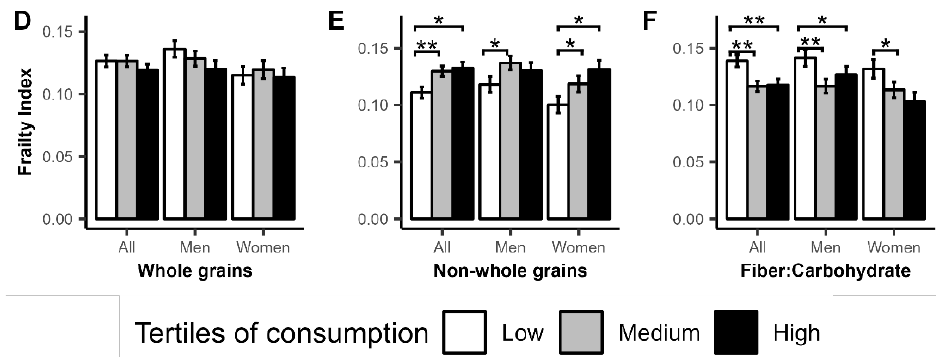
Figure 1. Associations between Frailty Index (FI) and tertiles of consumption of the different carbo- hydrate categories. Associations between tertiles of carbohydrate consumption and FI were assessed using multiple linear regression adjusted for age, sex, and total energy, BMI, diabetes, percent energy from polyunsaturated fatty acids (PUFA), saturated fatty acid (SFA), monounsaturated fatty acid (MUFA), and total fiber (except for the analysis of fiber-to-carbohydrate ratio). The graph represents mean FI by tertiles of consumption of percent energy from carbohydrate ( A ), glycemic load ( B ), total grains ( C ), whole grains ( D ), non-whole grains ( E ), and ratio of fiber to total carbohydrate ( F ). ** p ≤ 0.001, * p ≤ 0.05.